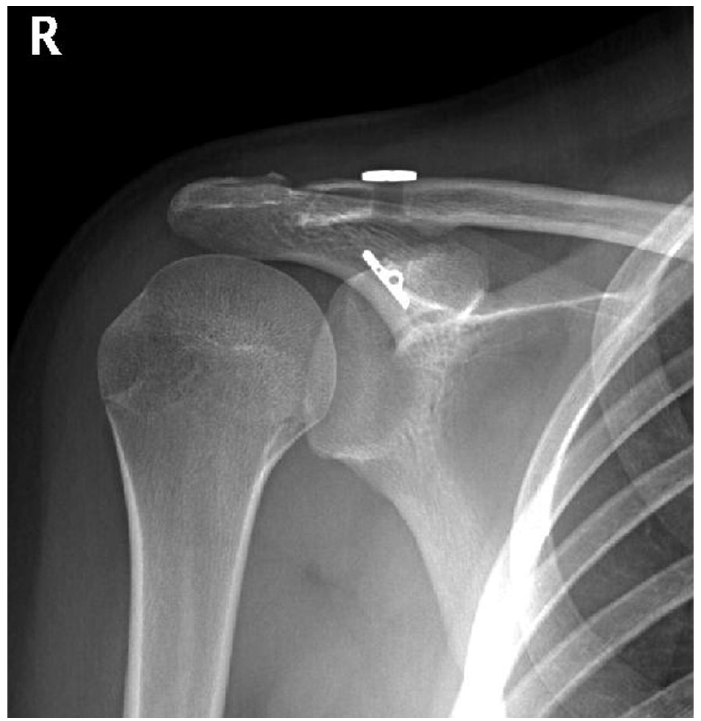
Figure 5. Postoperative radiographic control, with hyper shortening of the acromioclavicular joint.